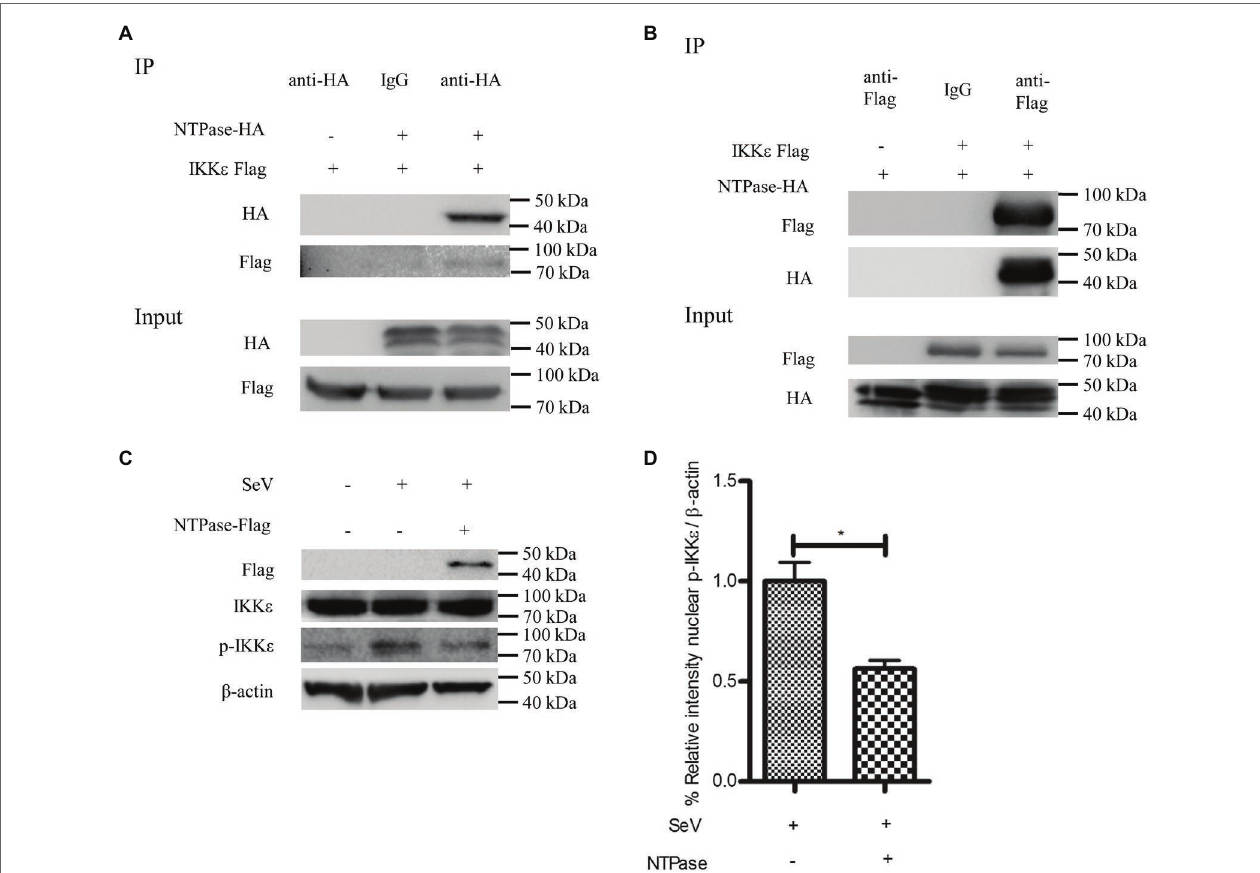
FIGURE 5 | HuNoV NTPase interacts with IKK ε and inhibits its phosphorylation. (A,B) HuNoV NTPase interacts with IKK ε . (A) HEK 293T cells in 6-well plates were cotransfected with 1.5 μ g plasmid expressing Flag-tagged IKK ε together with 1.5 μ g HA-tagged NTPase expression plasmid or empty vector for 40 h. Cells were lysed and subjected to coimmunoprecipitation (Co-IP) using rabbit anti-HA Ab. (B) HEK 293T cells in 6-well plates were cotransfected with 1.5 μ g HA-tagged NTPase expression plasmid together with 1.5 μ g plasmid expressing Flag-tagged IKK ε or empty vector for 40 h. A mouse anti-Flag Ab was used for Co-IP of cell lysates with normal IgG being used as a negative control. IP products and 5% input samples were examined by WB using anti-HA and anti-Flag Abs. (C) HuNoV NTPase inhibits the phosphorylation of IKK ε . HEK 293T cells in 6-well plates were transfected with 3 μ g plasmid expressing NTPase or empty vector for 24 h and then stimulated with or without SeV for 16 h. Total protein was isolated. WB was performed to examine IKK ε and p-IKK ε using corresponding Abs. The expression of NTPase was monitored using anti-Flag Ab. (D) Blot intensity for p-IKK ε was quantified using Image Lab with statistical significance being analyzed from three independent experiments. One representative experiment out of three is shown for WB. For graphs, data shown are mean ± SD of three independent experiments, with each condition performed in triplicate. * p <